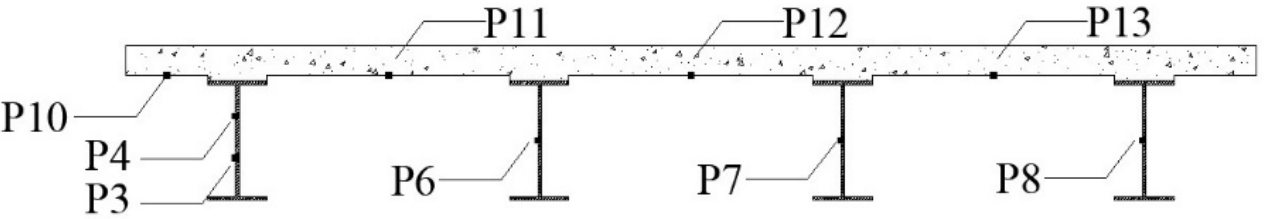
Figure 4. Locations of the pressure gauges used in the validation study.